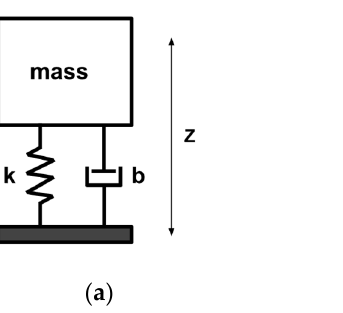
Figure 4. ( a ) Mass-spring-damper model of the MEMS accelerometer; ( b ) the MEMS accelerometer mode shape corresponding to the natural frequency of 3284 Hz.